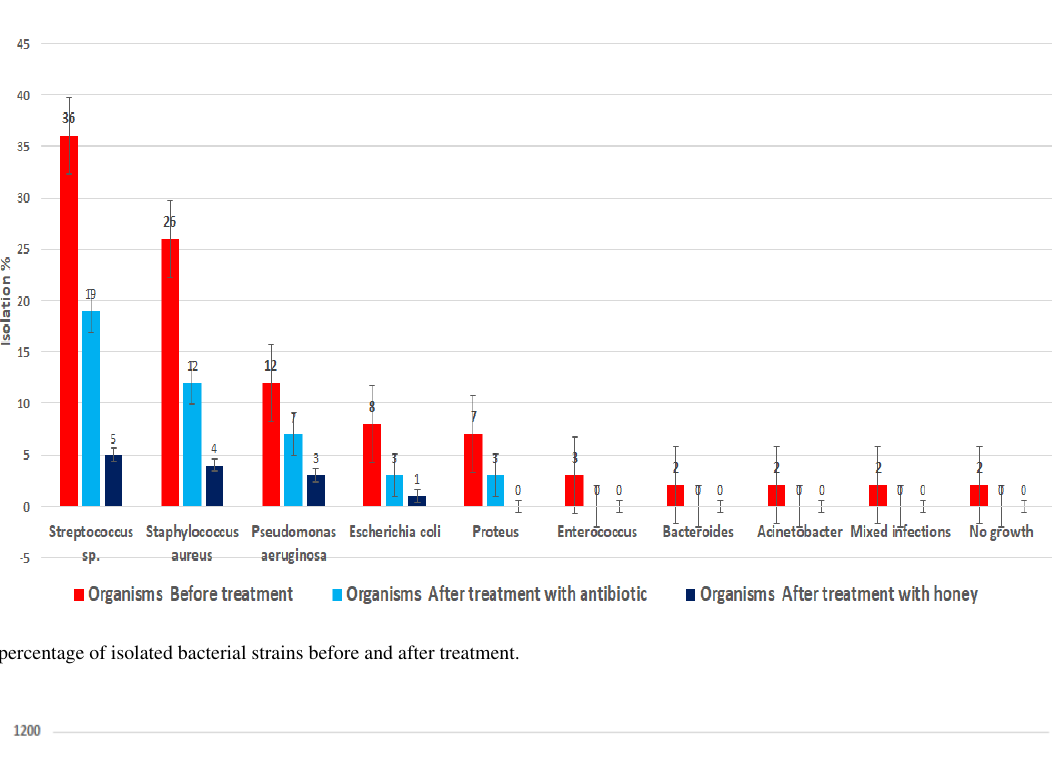
Figure 4. The percentage of isolated bacterial strains before and after treatment.